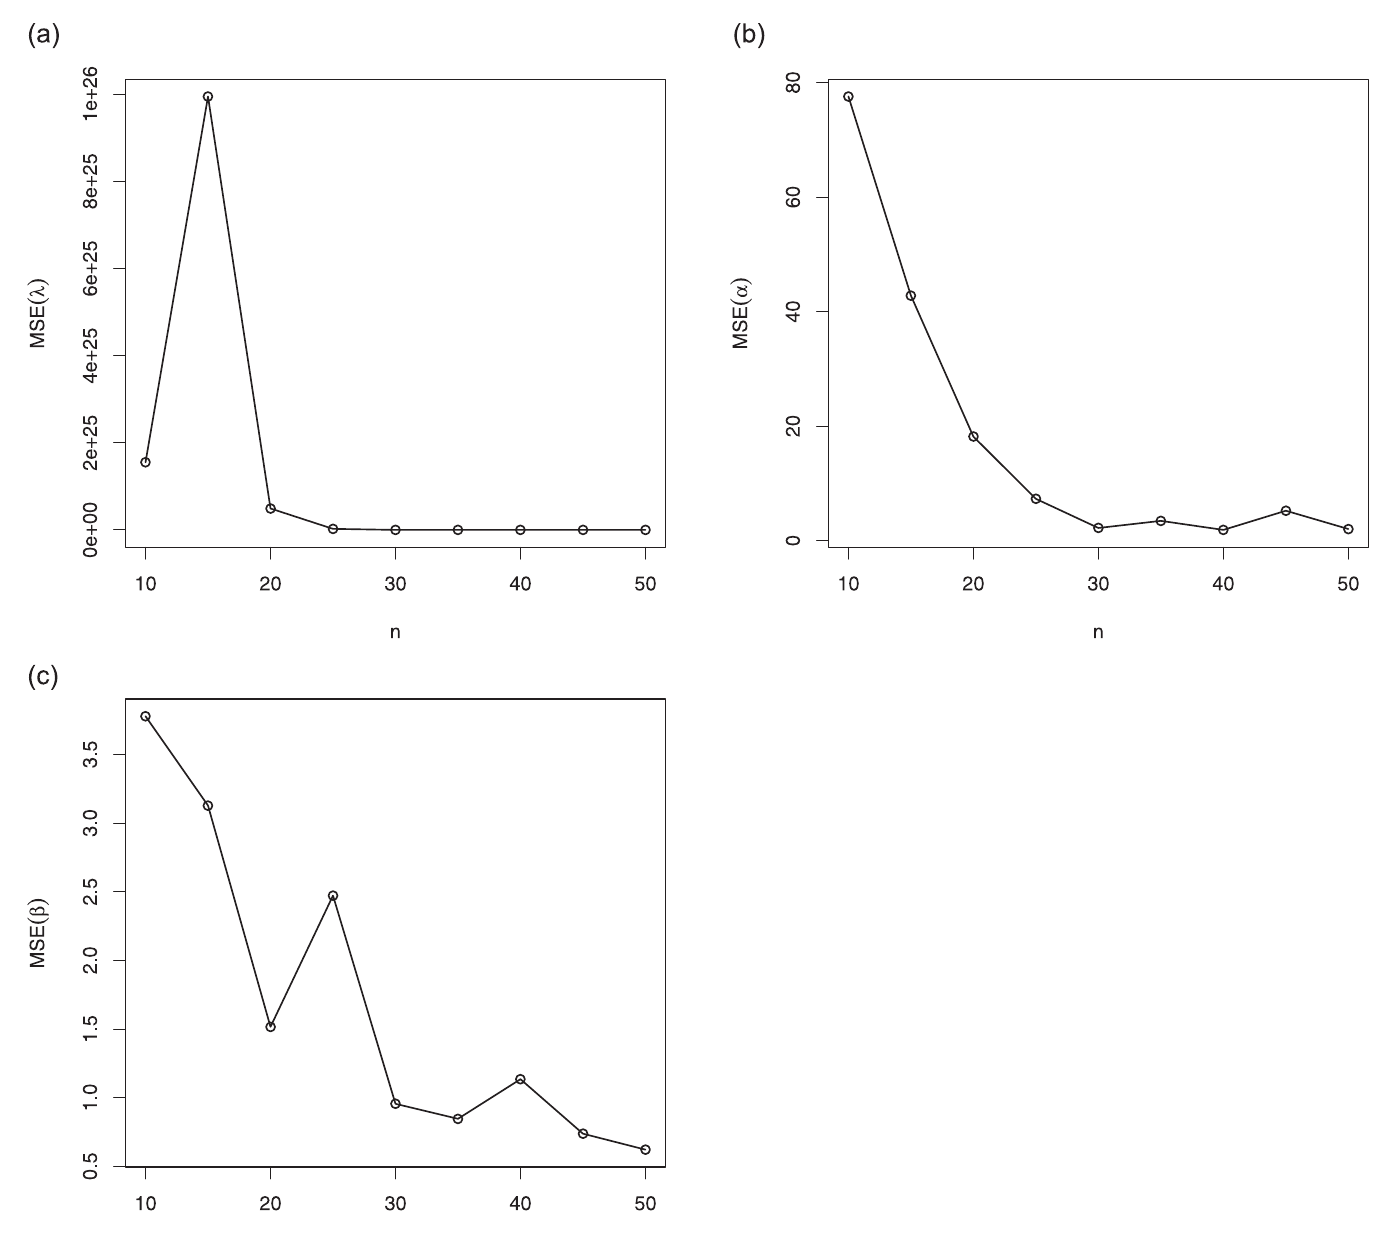
: ð λ ¼ 0 : 1 ; α ¼ 3 : 5 ; β ¼ 4 : 5 Þ for (a) λ , (b) α and (c) β 2